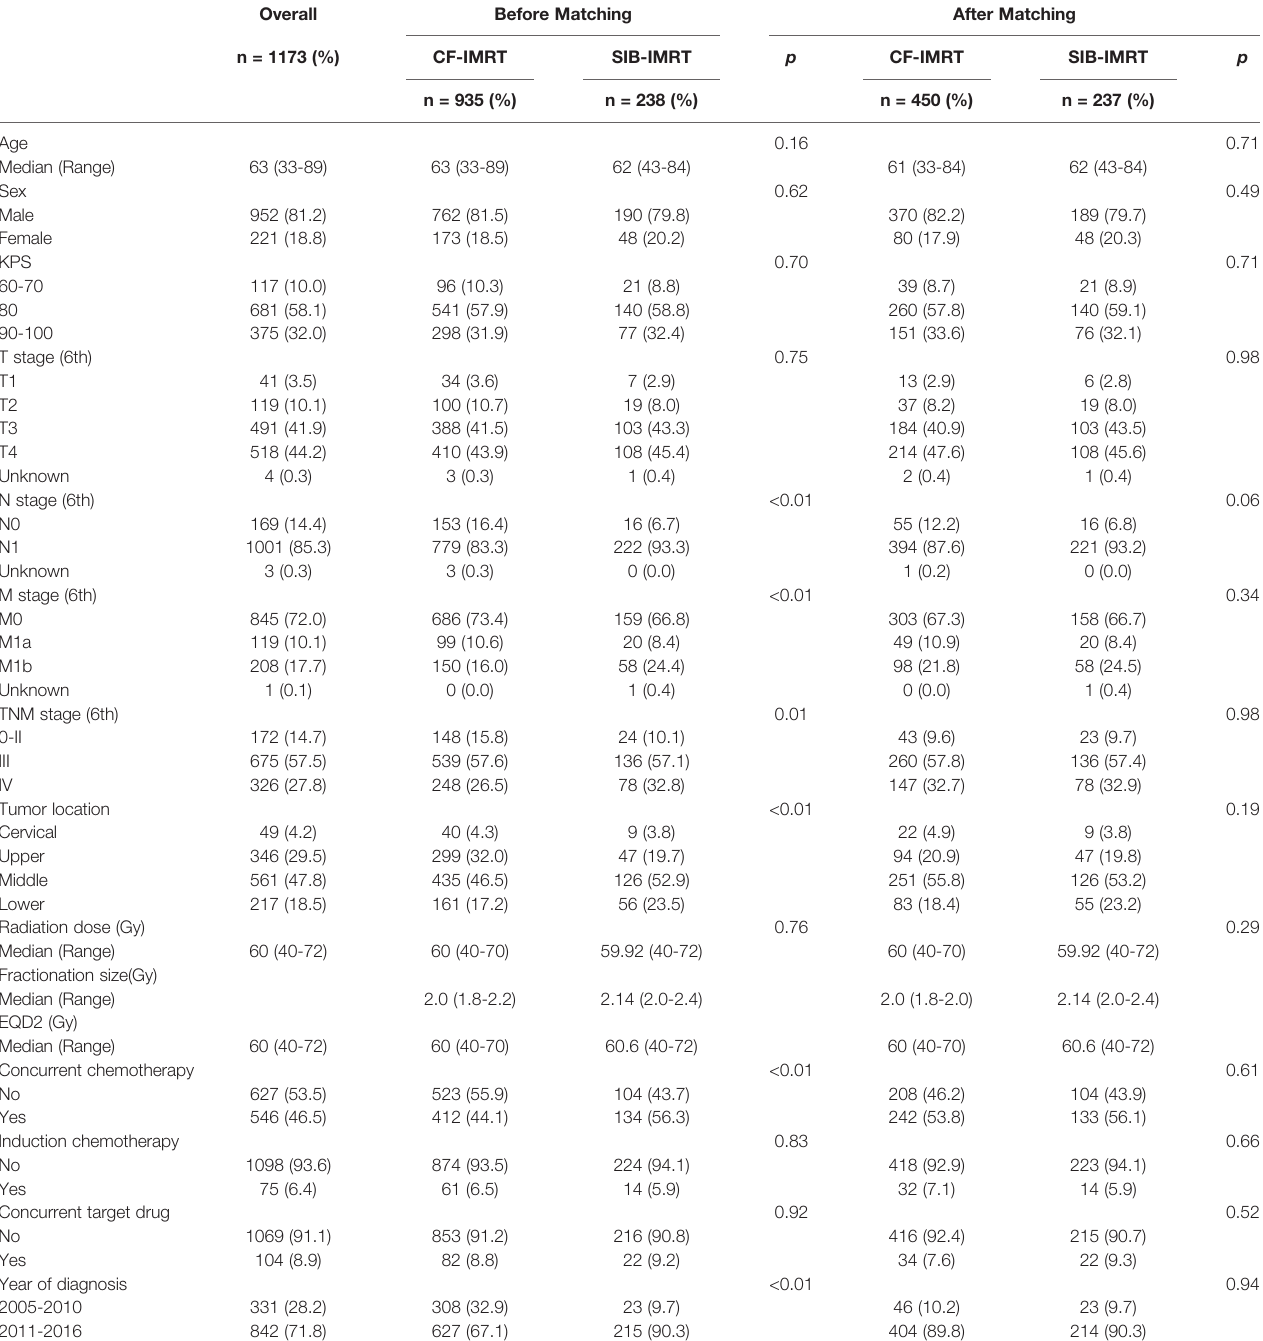
TABLE 1 | Patient, tumor, and treatment characteristics, before and after propensity score matching. Overall Before Matching After Matching n = 1173 (%) CF-IMRT SIB-IMRT p CF-IMRT SIB-IMRT p n = 935 (%) n = 238 (%) n = 450 (%) n = 237 (%) Age